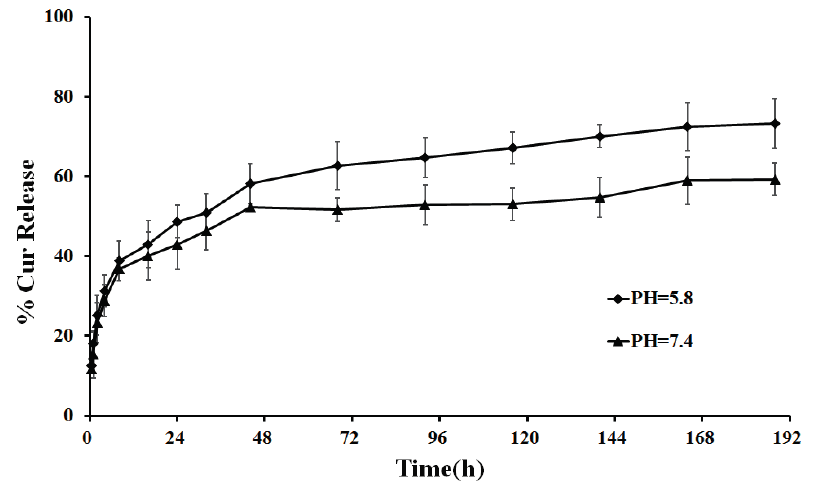
Figure 4. In vitro release of CUR-GAP NPs under acidic (pH 5.8) and neutral (pH 7.4) conditions at 37 °C. Data are mean ± SD, n =